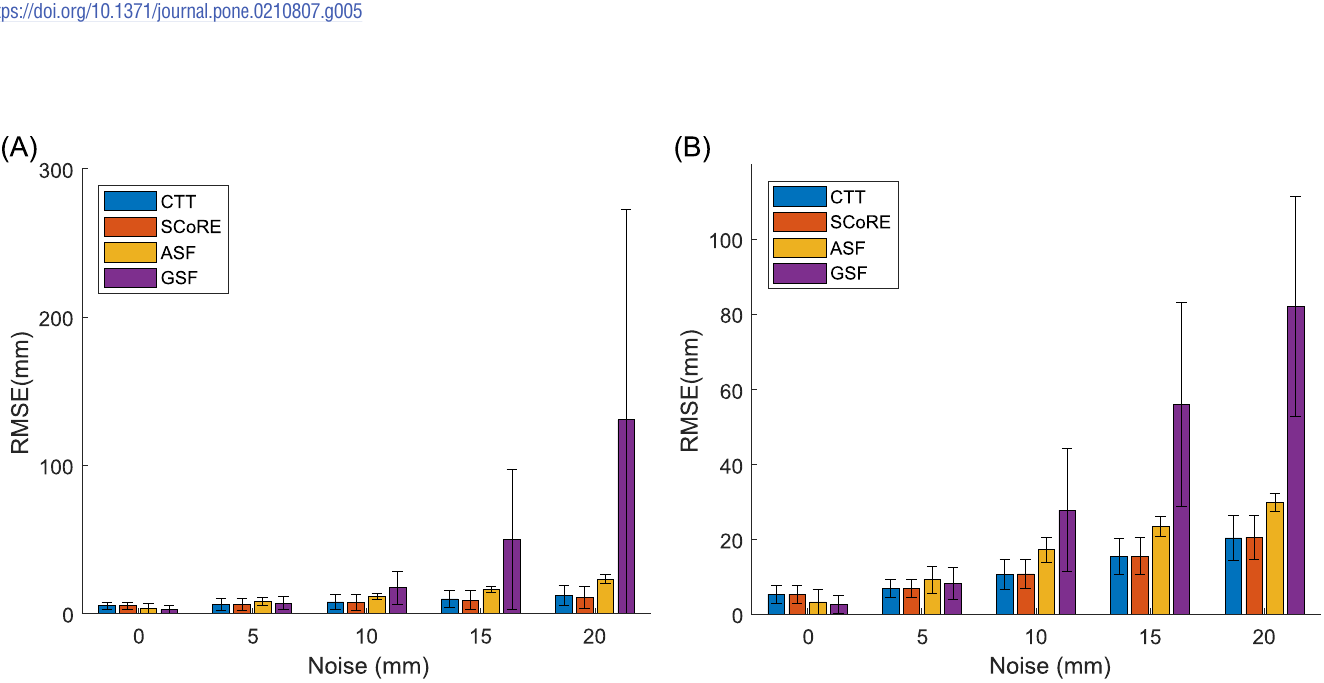
Fig 5. Contribution of the distal marker placement to the CoR estimation. Average root mean square error (RMSE) distribution of the distal coordinate origin varied in the frontal and transverse planes were computed for the CTT and SCoRE while the correlation between the centroid of markers and RMSE was analysed for the GSF and ASF methods.